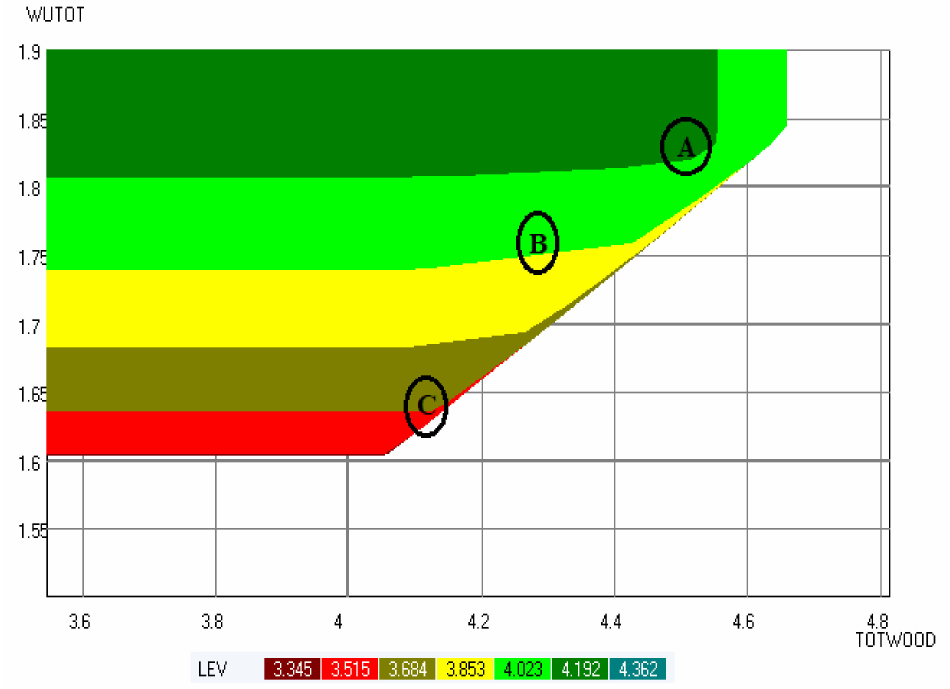
Figure 9. Pareto front points in a three-dimensional decision map showing tradeoffs among LEV, harvested wood and total water